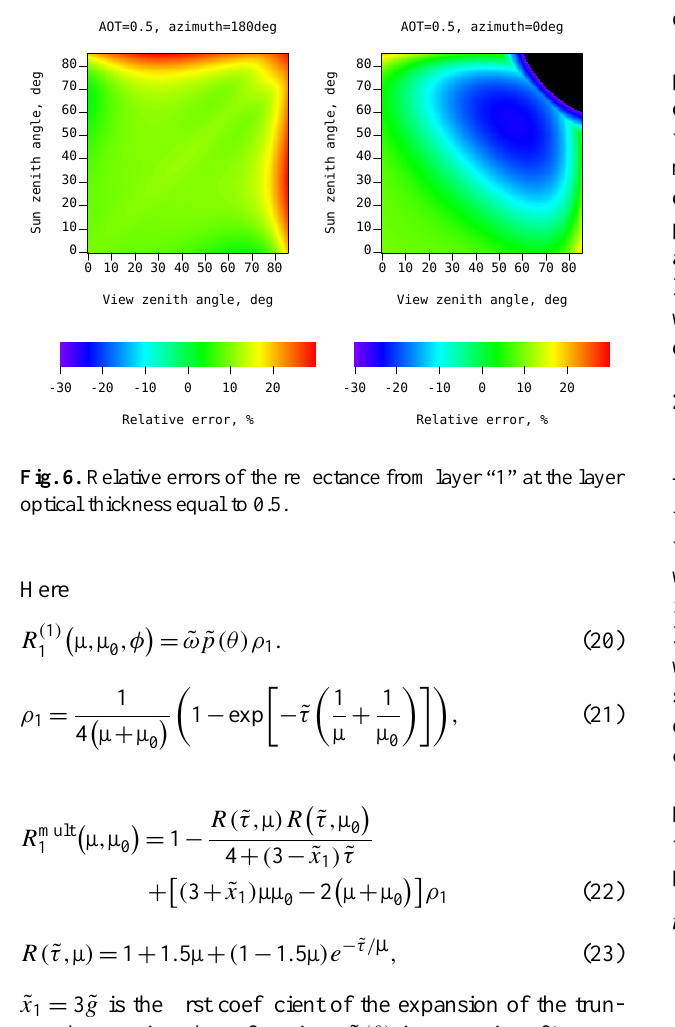
Fig. 5. Relative errors of the reflectance from layer “1” at the layer optical thickness equal to 0.2.